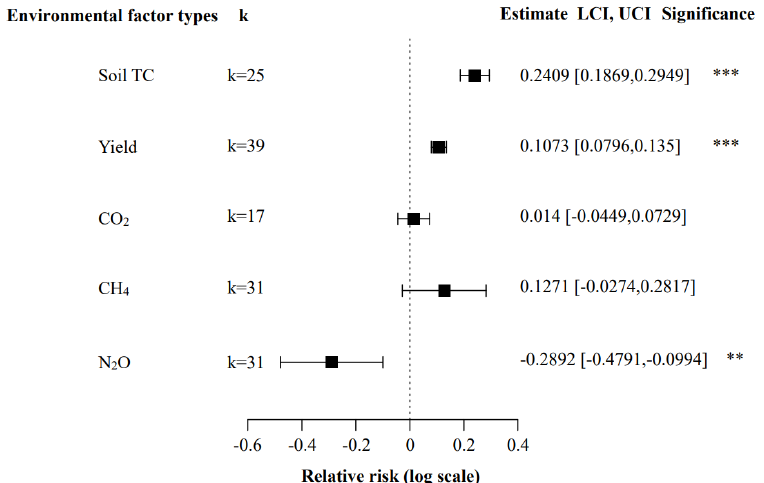
Figure 1. Analysis of the heterogeneity of carbon emission factors under the circumstances of applying biochar to paddy soils. Estimate stands for mean effect size; ** and *** indicate statistical significance levels at 0.01 and 0.001, respectively; k stands for number of samples; values in brackets mean LCI (the bottom of 95% confidence interval) and UCI (the ceiling of 95% confidence interval).